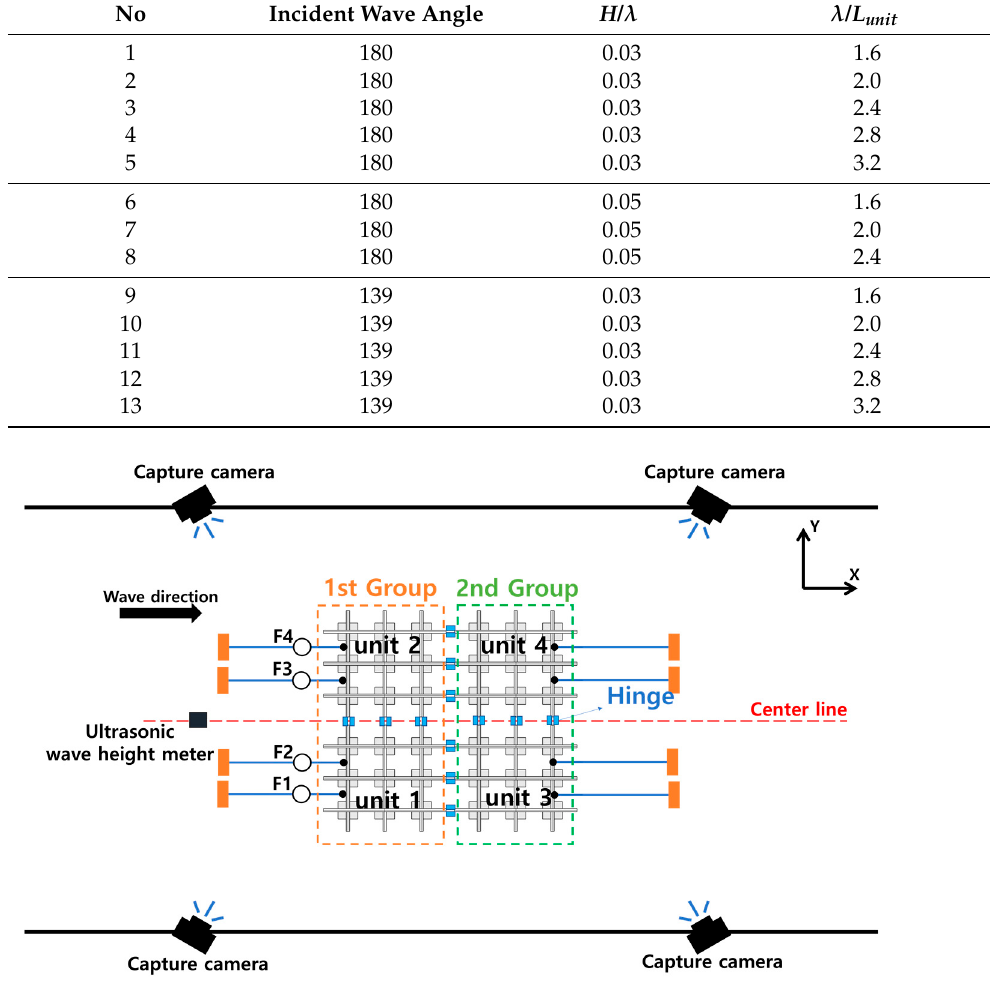
Figure 4. Diagram of the experimental setup for head sea conditions.